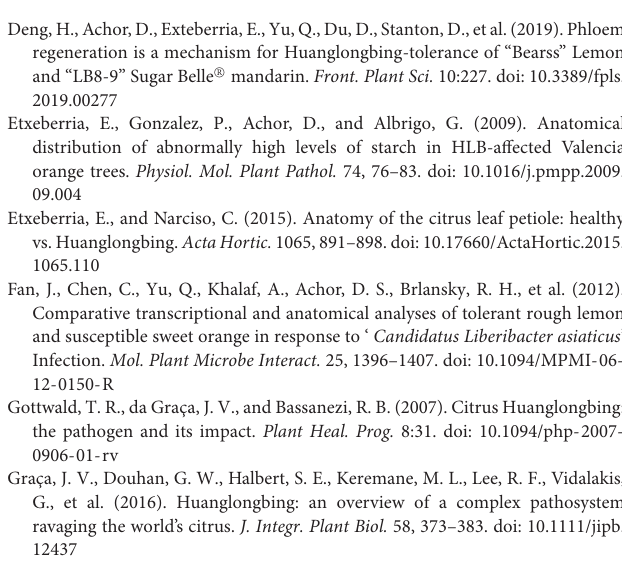
annotation of differentially regulated gene classes.